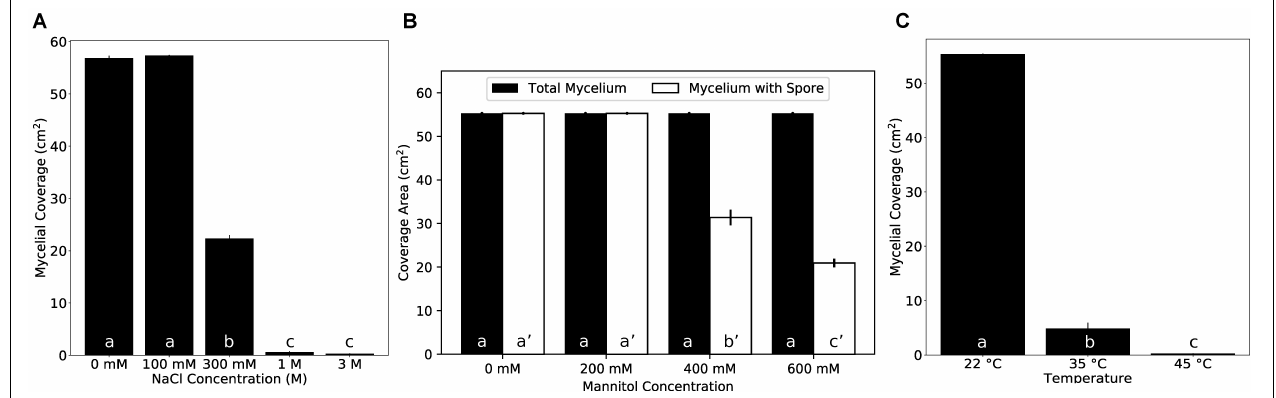
FIGURE 4 | Growth of the Trichoderma strain under various conditions on KM plates. (A) Fungal growth on different NaCl concentrations. (B) Fungal growth on different mannitol concentrations. (C) Fungal growth at different temperatures. Error bars represent SEs from three independent biological replicates. Statistical significance was determined by Tukey’s HSD test with P < 0.05, and is indicated by different lower-case